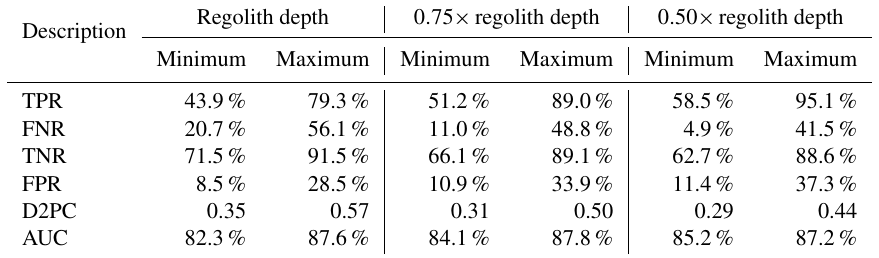
Table 7. Prediction rates of the model ensemble for the landslide-triggering rainfall event in May 1999. Three scenarios for the initial depth of the groundwater table in relation to regolith depth are considered. TPR: true positive rate; TNR: true negative rate; FPR: false positive rate; FNR: false negative rate; D2PC: distance to perfect classification; AUC: area under the ROC curve.